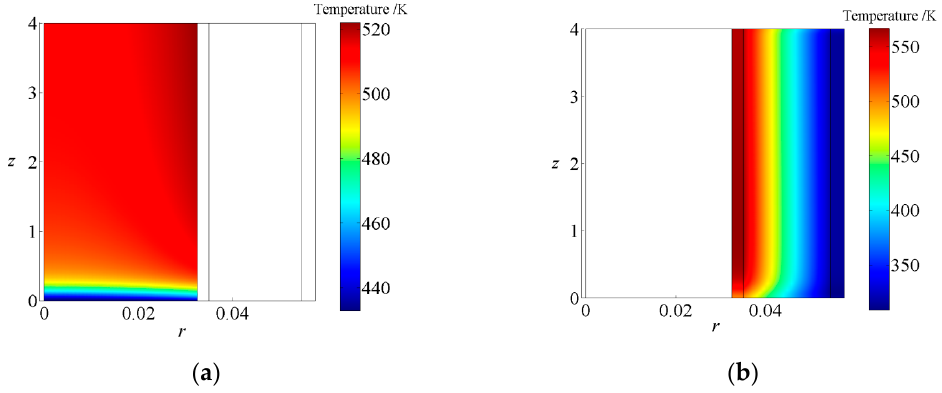
Figure 4. Temperature distributions of the MLTSRR. ( a ) Catalyst bed; ( b ) Receiver/reactor tube and glass tube.